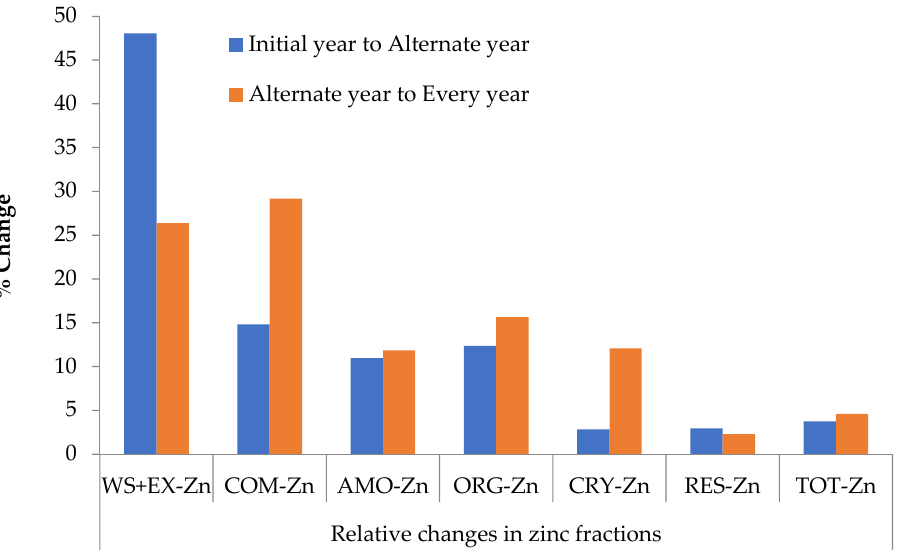
Figure 1. Effect of zinc application frequency on relative changes in different soil zinc fractions (%). All zinc fractions’ abbreviations are available in Table 2.